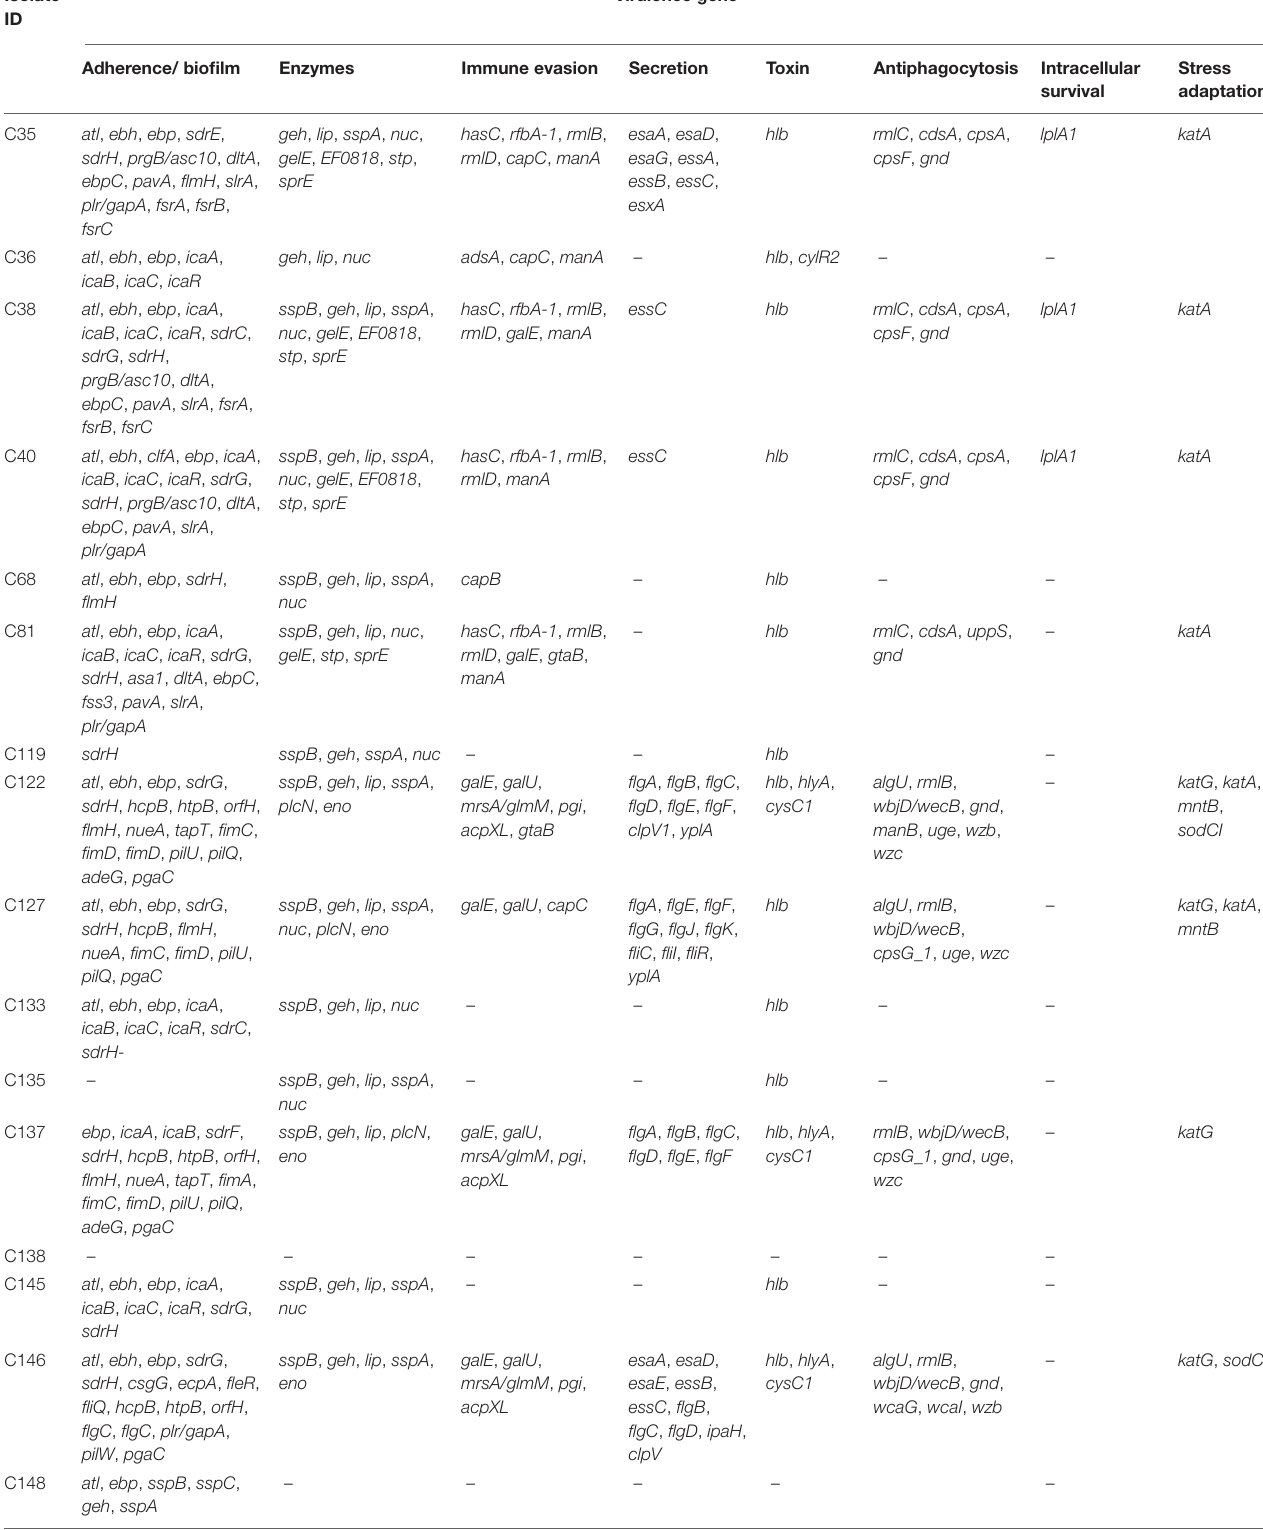
TABLE 5 | Virulence genes identified in MRSE isolates in this